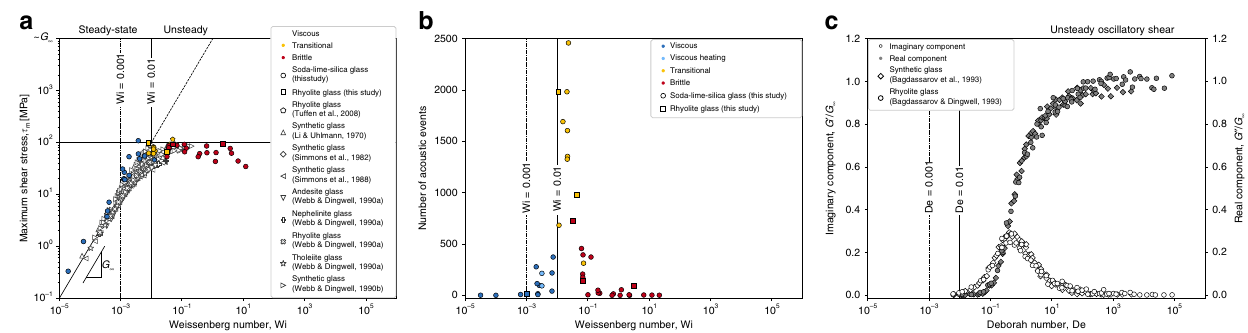
Fig. 5 The consequence of viscoelasticity for the emplacement behaviour of magmas. a At Wi < 10 − 2 , the maximum shear stress is τ m = G ∞ Wi, and at Wi > 10 − 2 , τ m = 10 − 2 G ∞ , which in the case of magmatic liquids is τ m ¼ Oð 10 2 Þ MPa, consistent with a reanalysis of data for synthetic 28, 44 – 46 and natural silicate liquids 35 . Here τ m is computed from σ m using the Trouton ratio for cylindrical geometry where appropriate. b The acoustic event number con fi rming fracture-formation during deformation of magmatic liquids at Wi ≳ 3 ´ 10 (cid:2) 3 and dominant acoustic activity at Wi = 0.01. c The viscoelasticity of a rhyolitic liquid oscillated at forcing frequency ω to low strain amplitudes, yielding a real G ′ and imaginary G ″ component of the elastic modulus 47, 48 as a function of the Deborah number De = ωλ r and showing the onset of elasticity at De = 10 − 2 , consistent with all data (Figs. 2 and